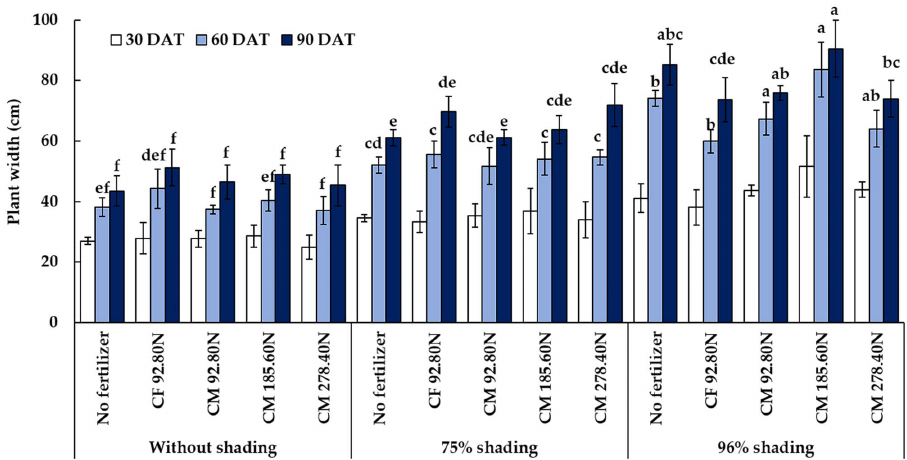
Figure 2. Plant width of vegetable fern grown under different shading and fertilizer application treatments at each DAT (days after transplanting). Values are means with standard deviations ( n = 4). The different letters above the bars indicate statistically significant differences by Duncan’s multiple range tests ( p < 0.05) within each harvesting month. Comparing different levels of shading, it was revealed that 75% shading had an influence ( p ≤ 0.05) on the total vegetable fern productivity in all three harvesting months, resulting in the maximum yields. In contrast, the 96% shading treatments produced the lowest overall yields of vegetable ferns. When fertilizer application was considered, it was discovered that it substantially impacted the total yield of vegetable fern during the third month of harvest ( p ≤ 0.05). The greatest vegetable fern yields of the first and second months were recorded in plots with cow manure fertilizer applied at a rate of 185.60 kg N ha −1 . This yielded 461.98 and 560.99 kg ha −1 , respectively. A rate of 278.40 kg N ha −1 of cow manure fertilizer did not significantly alter production in the first month (445.50 kg ha −1 ). However, the greatest vegetable fern yield of the third harvesting month was recorded in plots with cow manure fertilizer applied at a rate of 278.40 kg N ha −1 (Table 3). Interestingly, an interaction ( p ≤ 0.05) was observed between shading and fertilization, affecting the total yield of vegetable fern throughout all three harvesting months. The vegetable fern produced the highest overall yield when 75% shading was supplemented with cow manure fertilizer at a rate of 185.60 kg N ha −1 throughout all three harvesting months. Vegetable fern grown without shading or fertilization resulted in the lowest corresponding yields (Figure 3).